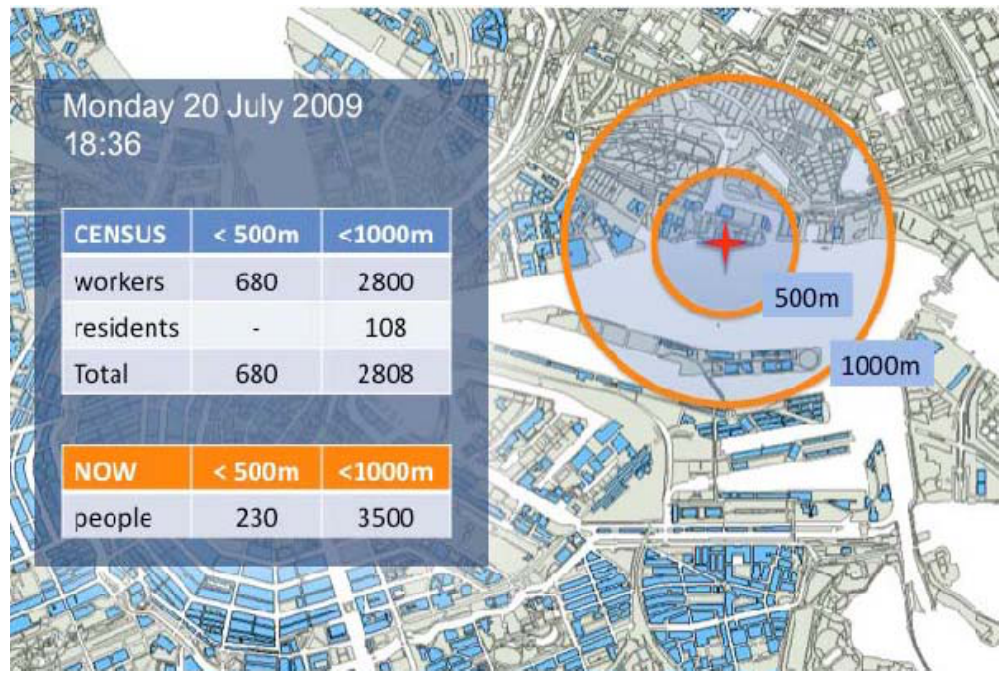
Figure 7. This screenshot from “CurrentCity 2010” illustrates the problem of “night-time oriented” census information and new ways to derive spatio-temporally disaggregated population